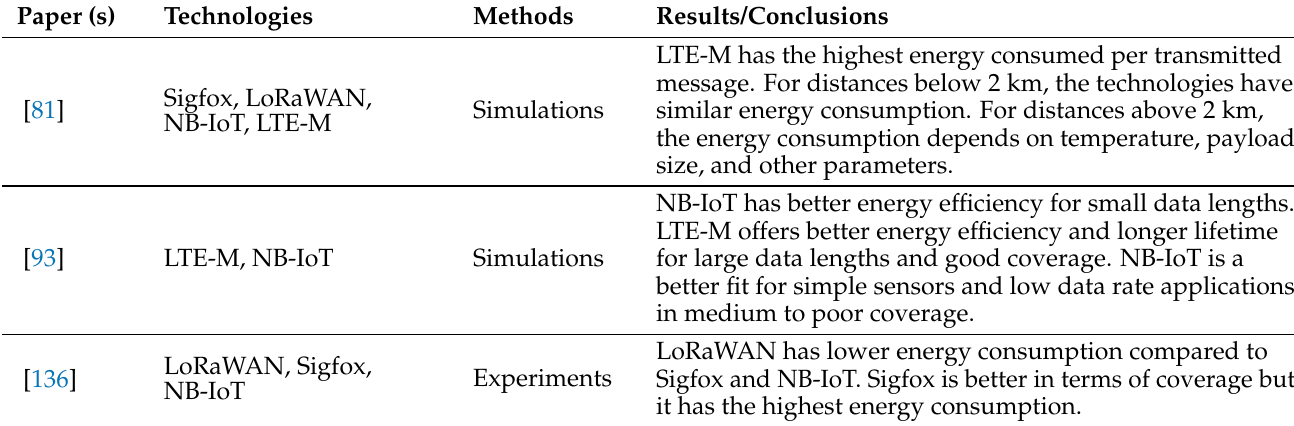
Table 4. Existing comparative analyses of Low-Power Wide-Area Networks (LPWANs) in terms of energy efficiency and consumption. Paper